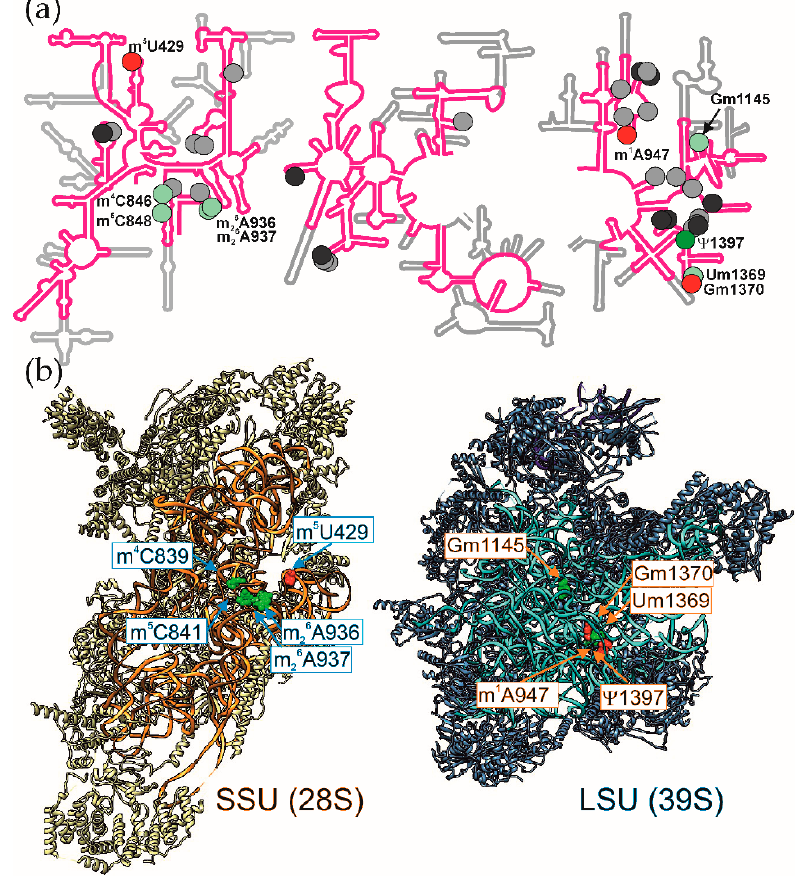
Figure 1. Location of the modified nucleotides in the mammalian mitochondrial rRNA. ( a ) Secondary structure [34] of human mitochondrial 12S rRNA (left) and 16S rRNA (right) are shown in pink superimposed onto that of E. coli 16S rRNA and 23S rRNA shown in grey. Nucleotides methylated in both bacterial and mitochondrial rRNA are shown by light green circles, while conserved pseudouridine is shown as a dark green circle. Red circles correspond to nucleotides modified exclusively in mt-rRNA. Modified nucleotides present in E. coli rRNA, but not in mt-rRNA are shown by light grey (methylated) and dark grey (pseudouridinylated) circles. ( b ) Tertiary structure of the human mitochondrial small (left) and large (right) ribosomal subunits [35]. Ribosomal proteins of the small subunit are shown as yellow ribbon, while that of the large subunit as steel blue ribbon. 12S rRNA is shown as orange ribbon; 16S rRNA as cyan ribbon, tRNA of the large subunit as blue ribbon. Methylated nucleotides of the mt-rRNA are shown as spacefilled objects and marked by the same colors as on the panel ( a ). UCSF Chimera [36] was used to create this illustration.